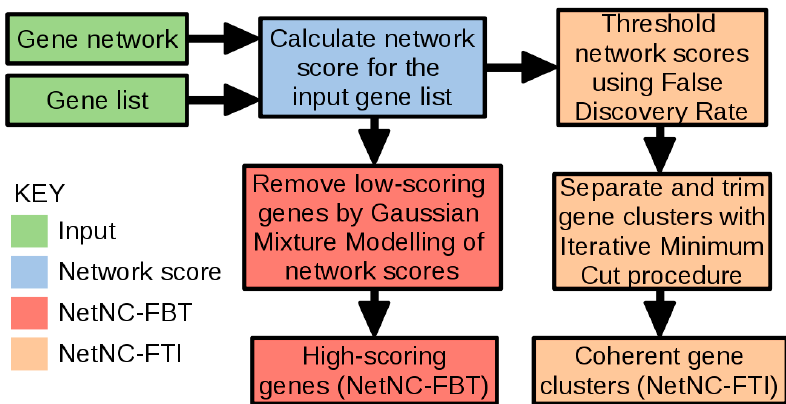
Figure 1. Overview of the NetNC algorithm. A gene network and a gene list are required by NetNC as input (green). The current study analyses candidate TF targets; however, NetNC could be applied to any gene list and network. NetNC calculates a network score (blue) using Hypergeometric Mutual Clustering (HMC) for each gene pair in the input gene list according to connections in the network. Two analysis settings are (a) NetNC-FBT (red), where Gaussian Mixture Modelling identifies high-scoring genes; (b) NetNC-FTI (orange), which produces coherent gene clusters by thresholding network scores according to False Discovery Rate followed by Iterative Minimum Cut.